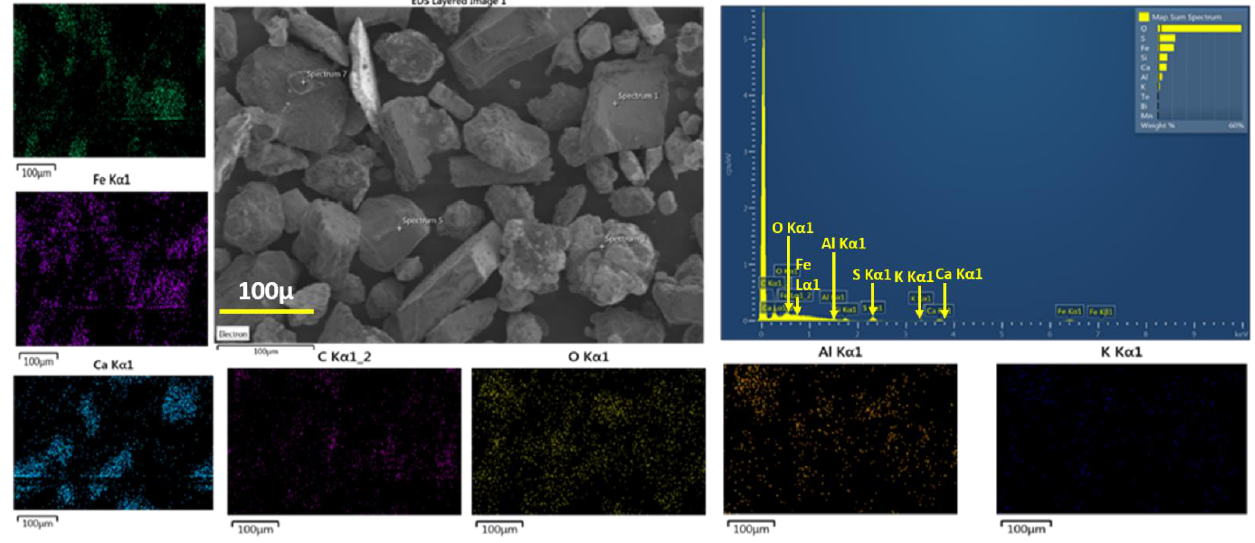
Figure 2. SEM imaging and EDS mapping of fine pyrite.